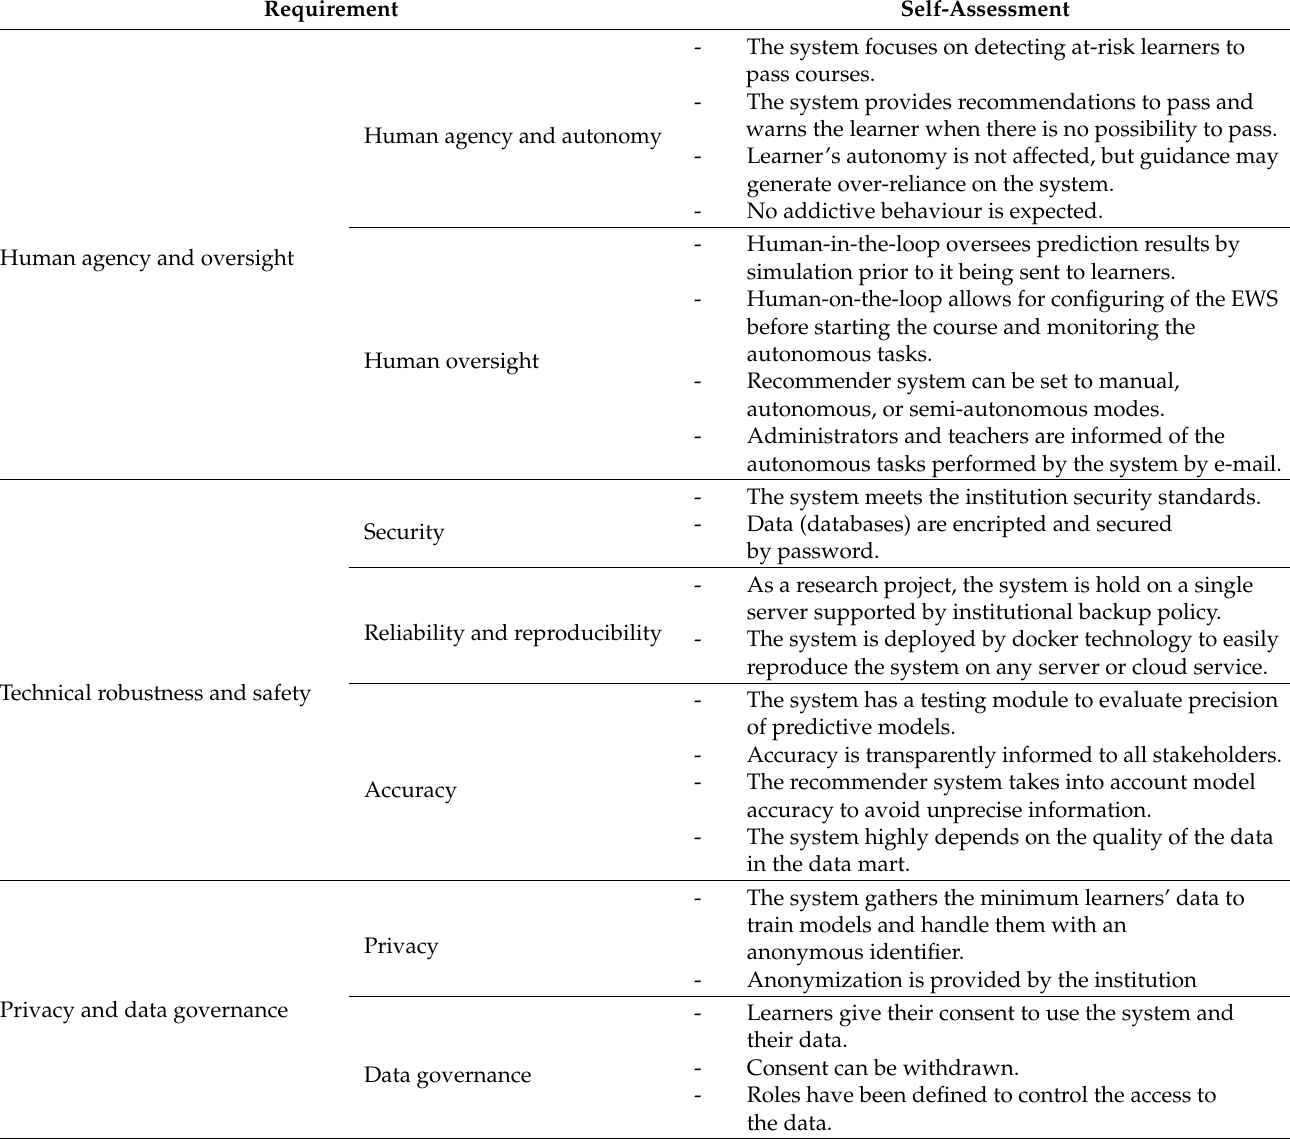
Table 1. Self-assessment of the ALTAI